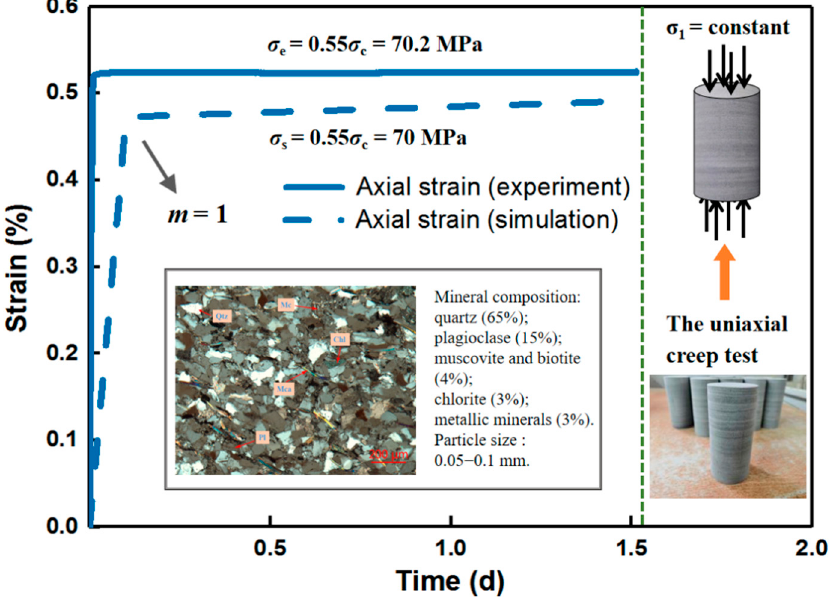
Figure 4. Comparison between experimental and numerical results.